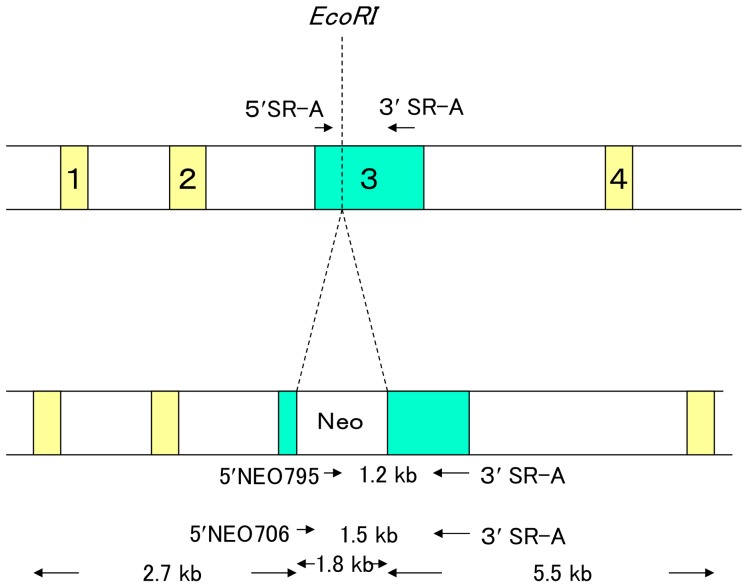
Targeting of the mouse SR-A gene.The SR-A genomic fragment was composed of exons 3 to 5. A 1.8-kb XhoI–SacI fragment of pGK1 neo-poly(A)+ was inserted into the EcoRI site in exon 3.